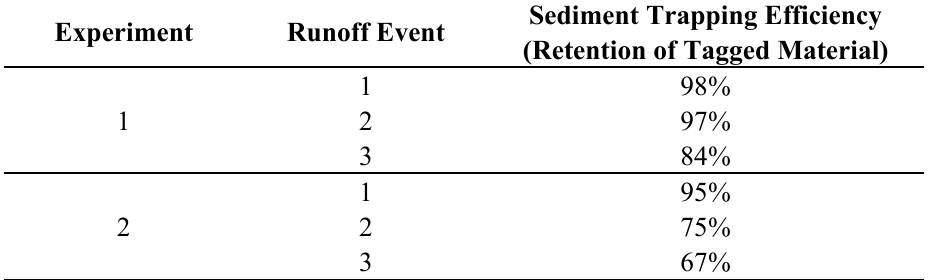
Table 2. Summary of sediment trapping efficiency (tagged sediment concentration leaving the swale-the total tagged concentration entering the swale) during artificial flow events (for two replicate artificial runoff experiment sets).